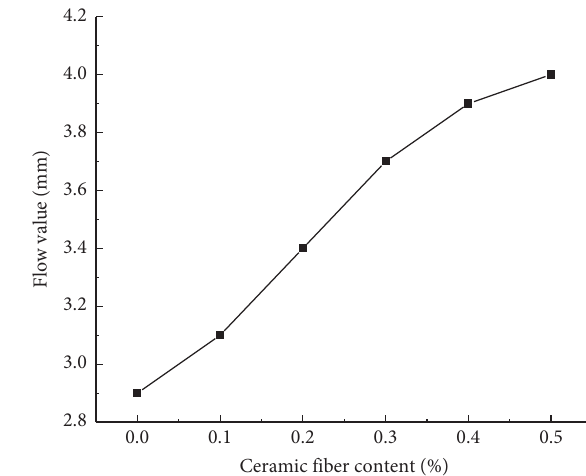
Figure 5: Relation between VV and CF content.